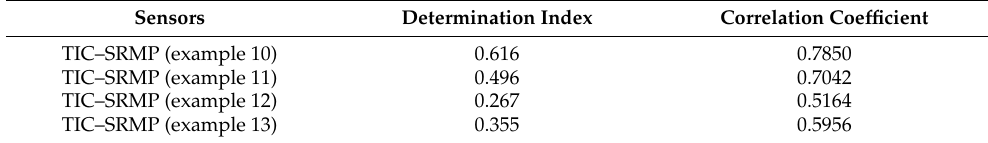
Figure 11. Scatter plot comparing the thermal imaging camera and the second rolling mill pyrome- ter. Table 7. Data analysis results ( modified plant configuration) for the billets of different clusters of steel quality and of the same diameter for the related finished products.